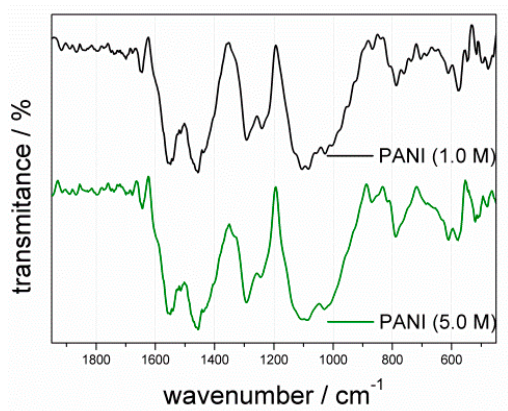
Figure 2. Fourier-transform infrared (FTIR) spectra of polyaniline (PANI) powders: PANI (1.0 M) (black line); PANI (5.0 M) (green line).